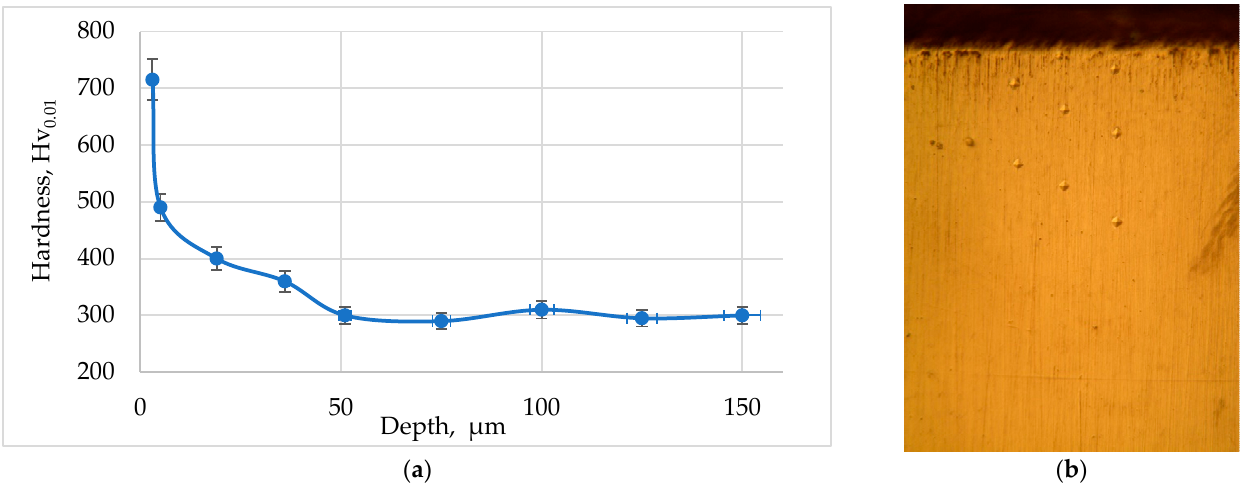
Figure 6. Hardness profile of the nitrided BT22 alloy ( a ) and the oblique section with indents ( b ).